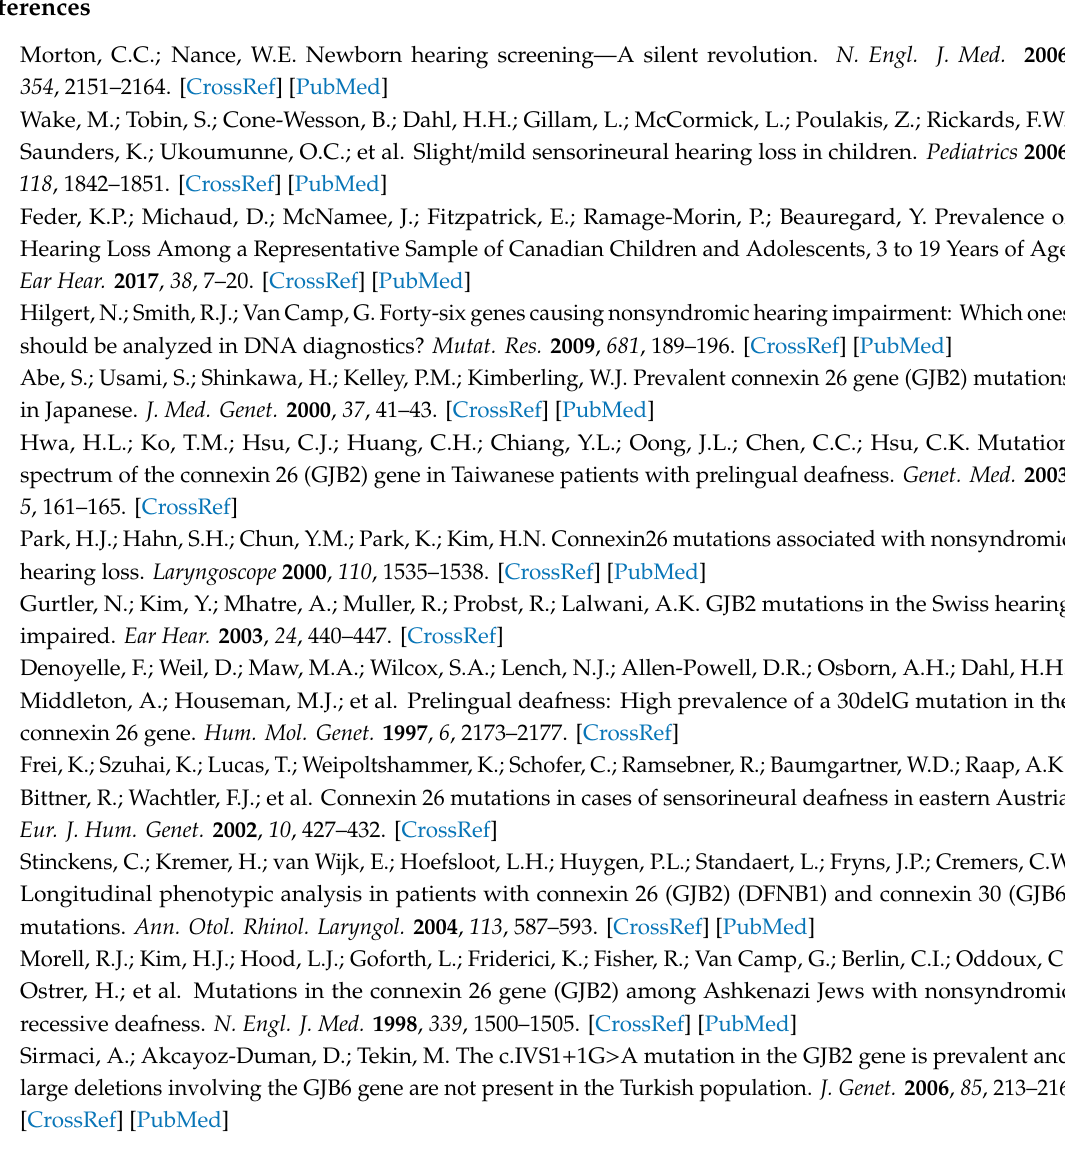
Table S1: All NCBI Reference Sequences of other deafness